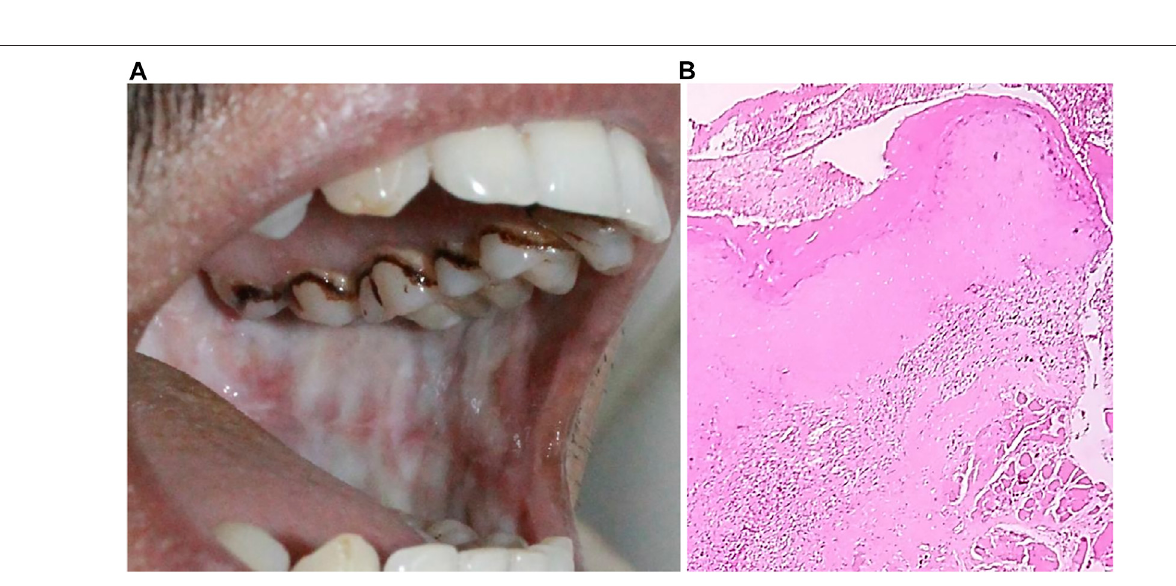
Frontiers in Pharmacology |